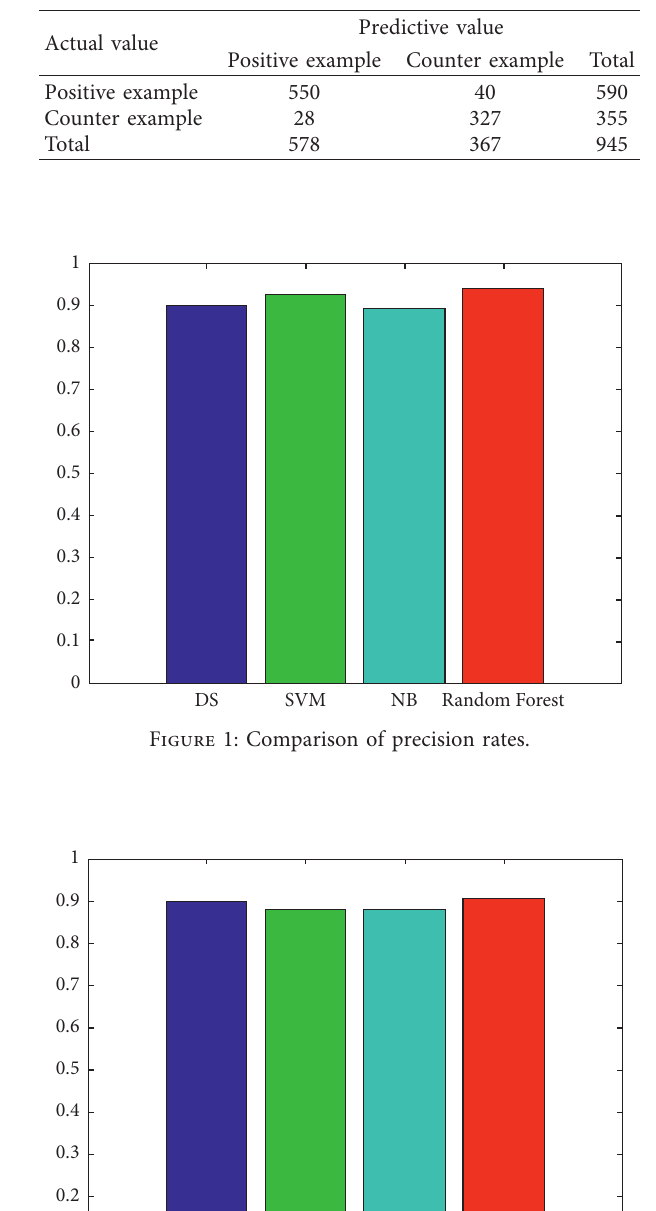
Table 4: Confusion matrix of RF classification results.